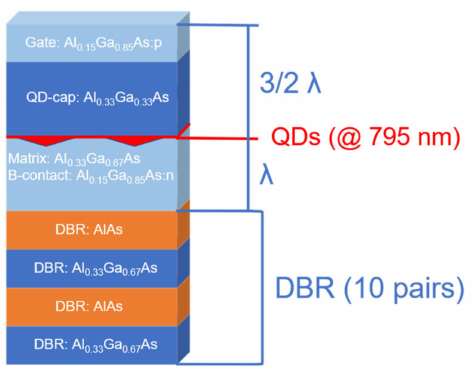
Figure 4. Design schematic of the photonic sample. Color scheme: Orange is AlAs, deep blue is Al 0.33 Ga 0.67 As, and light blue is Al 0.15 Ga 0.85 As. The QD material is GaAs (red). The 10 nm Al 0.33 Ga 0.67 As matrix is neglected.